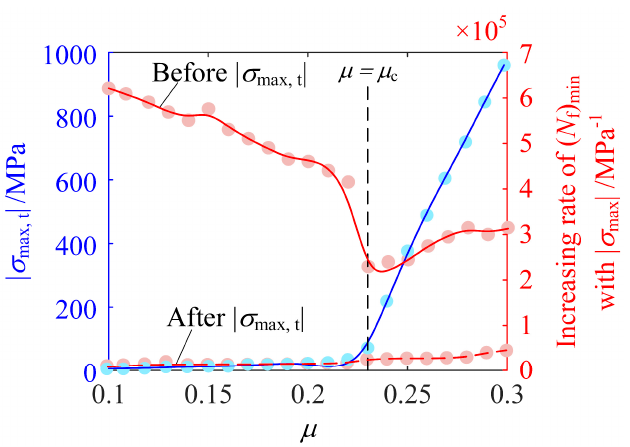
Figure 14. | σ max,t | and the increasing rate of ( N f ) min with | σ max | before and after | σ max,t | as functions of μ .